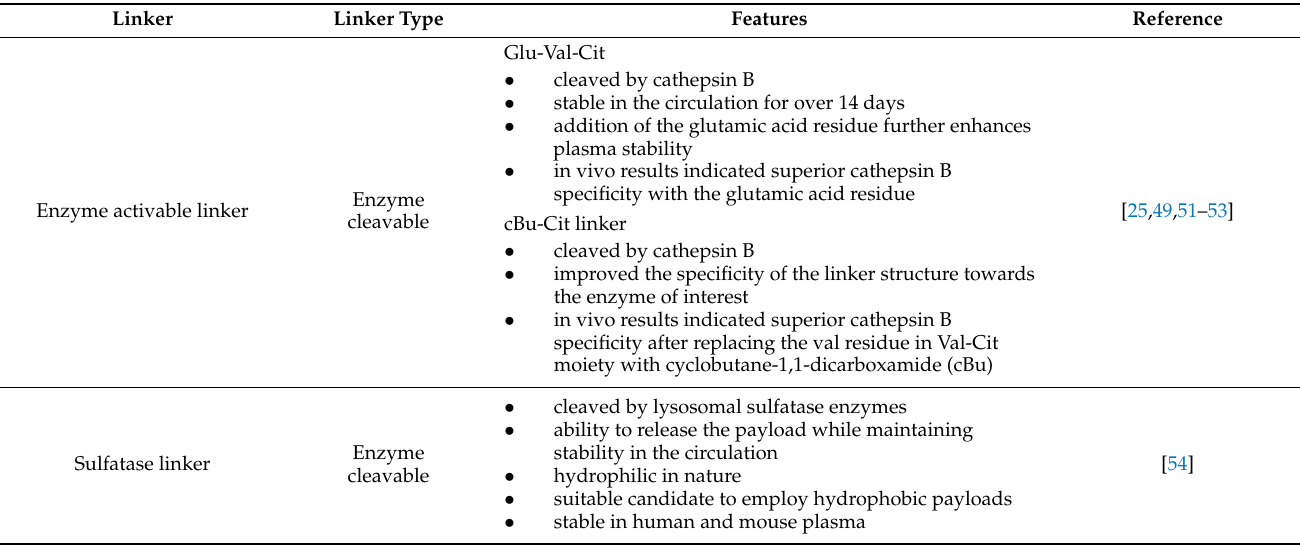
Table 2. Enzyme and chemically cleavable